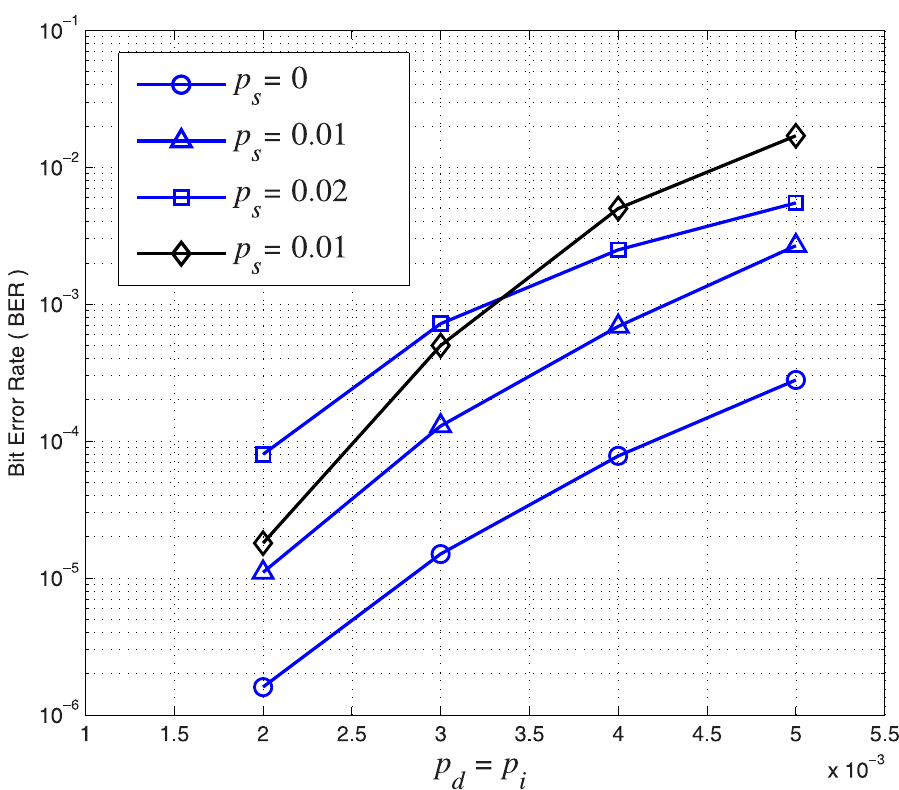
Fig 11. Comparision performance under different channel parameters. p and p s increases from 0 to 0.02. Blue curves represent concatenated LDPC-marker codes under different p s and the black curve represents the best code in [16] when p